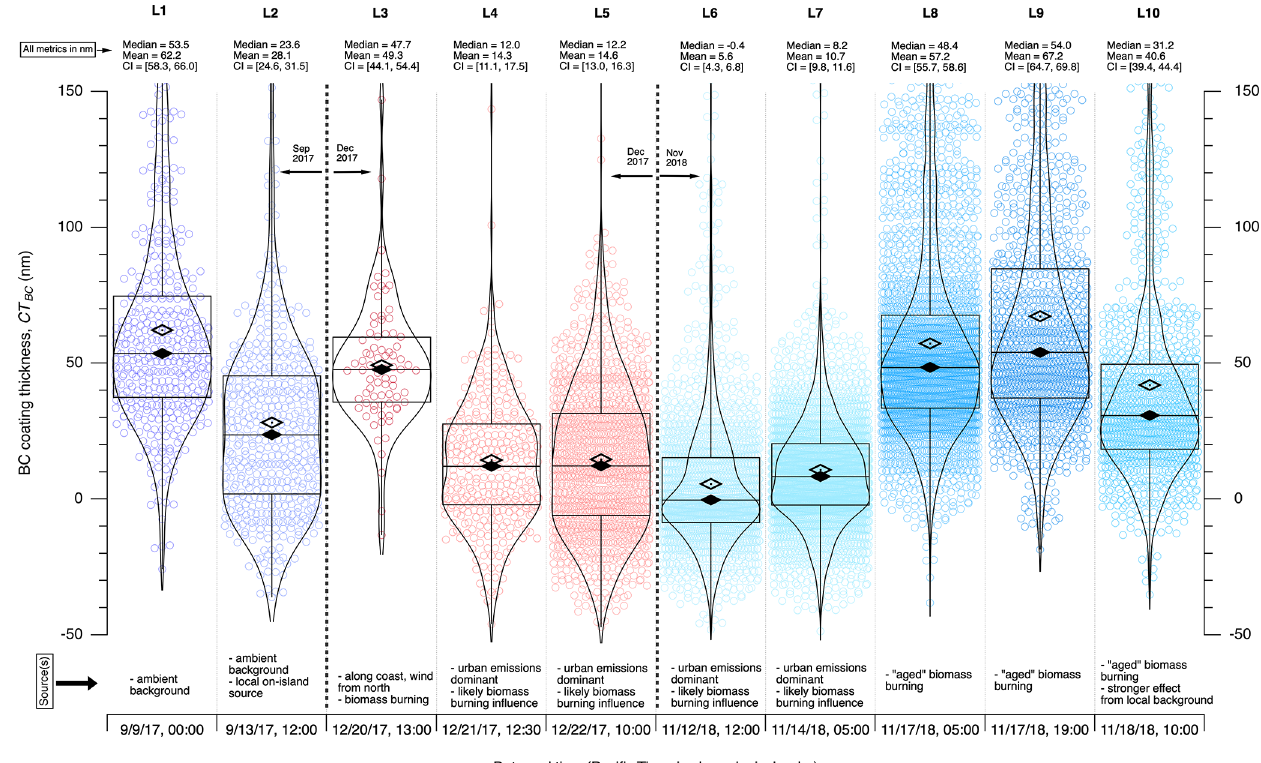
Figure 10. Violin plots that show the distribution of rBC coating thickness values for particles with rBC diameters between 200 and 250nm, calculated for each LEO time period, L1 through L10. Each circle marker in the plot represents a particle analyzed by the LEO analysis and the curves for each “violin” shape represent the normalized probability density function of the coating thickness for each LEO period. The violin shape results from mirroring each probability density distribution along a vertical axis. Box-and-whiskers plots are also overlaid to show the quartiles (25th, 50th, and 75th percentiles) of the coating thickness distributions. The 95% confidence intervals (CI) based on a Student’s t distribution are shown above each violin plot to demonstrate when the mean coating thickness values are statistically distinguishable from one another. The mean (unfilled diamond) and median (solid diamond) coating thicknesses are also indicated above each violin plot, and a brief description of sources for each LEO period is annotated below each distribution. Dates on the x axis are given in the following format: